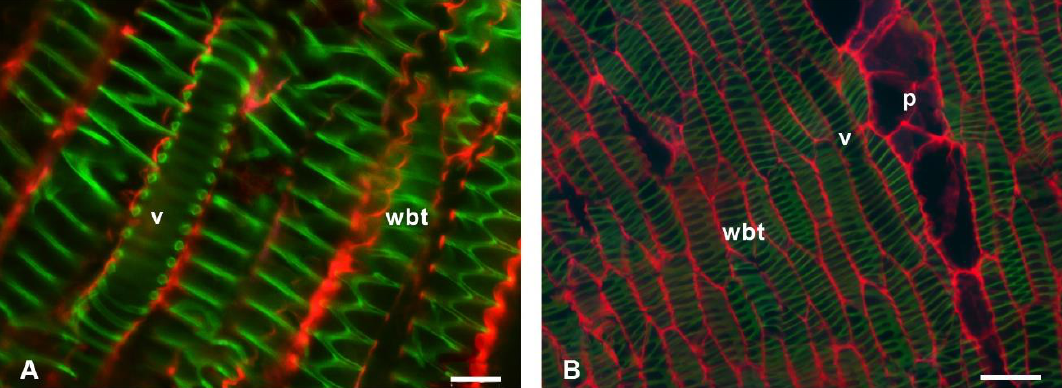
Figure 6. Fluorescence emission of longitudinal sections of non-fibrous wood species of Cactaceae. ( A ) Carpathia delaetiana. ( B ) Neolloydia conoidea . p = parenchyma, v = vessel, wbt = wide-band tracheids. Scale: 20 µm: A,B.